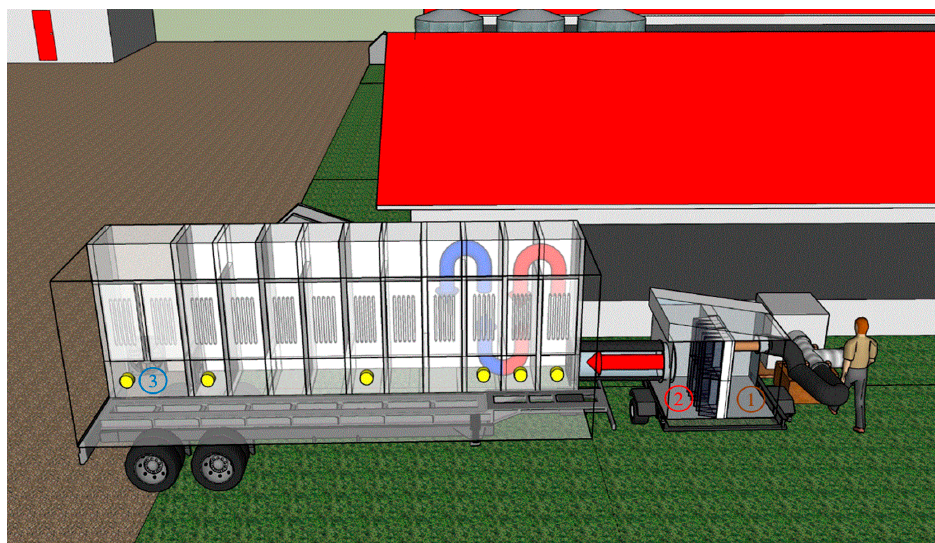
Figure 2. Schematic of an airborne pathogen sampling system. Red arrow: Sampled air with the viable and non ‐ viable particulate matter emitted from the swine barn ventilation fan and trapped in biosample impingers; Blue arrow: Vacuum ‐ induced airflow.